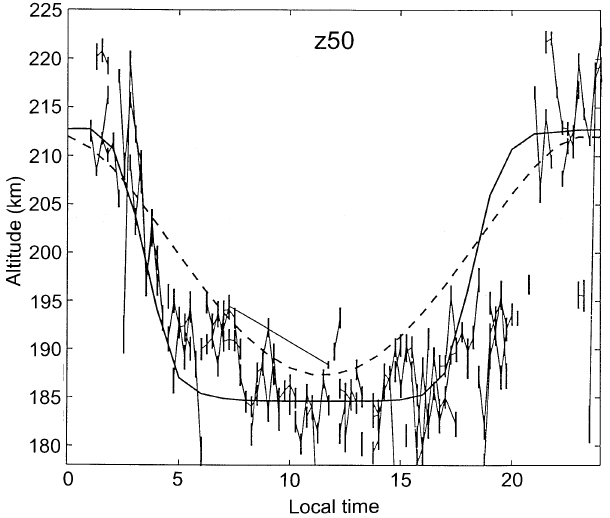
Fig. 4. Daily variation of the transition altitude during quiet